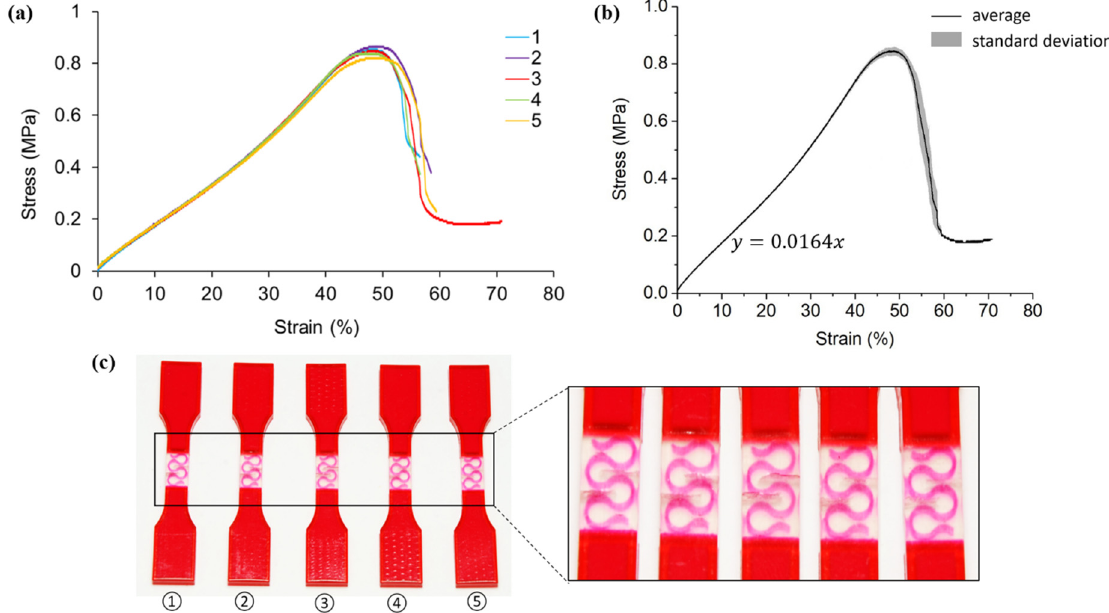
Figure 6. ( a ) Stress-strain curves obtained from tensile testing tests on hybrid case two (pure vertical first order) samples; ( b ) average tensile stress-strain curve and standard deviation of all five testings; ( c ) pictures of failed tensile samples with magnification at the locations of fracture.